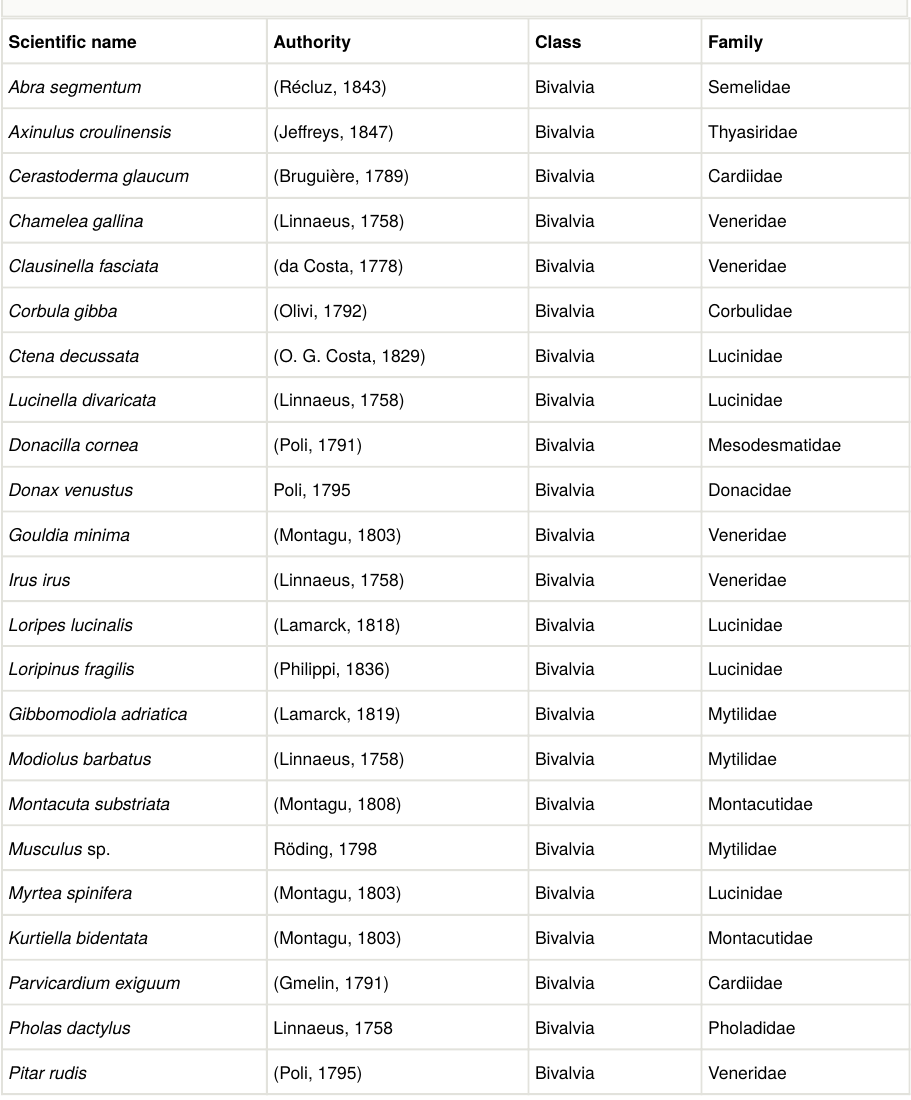
Description: The taxonomic coverage of the dataset is limited to the molluscan assemblages of the study area. Speci fi cally, the dataset includes gastropod, bivalve and scaphopod species. A list of the species included in the dataset, also indicating their taxonomic classi fi cation, is given in Table 2. Table 2. List of species included in the dataset, indicating their taxonomic classi fi